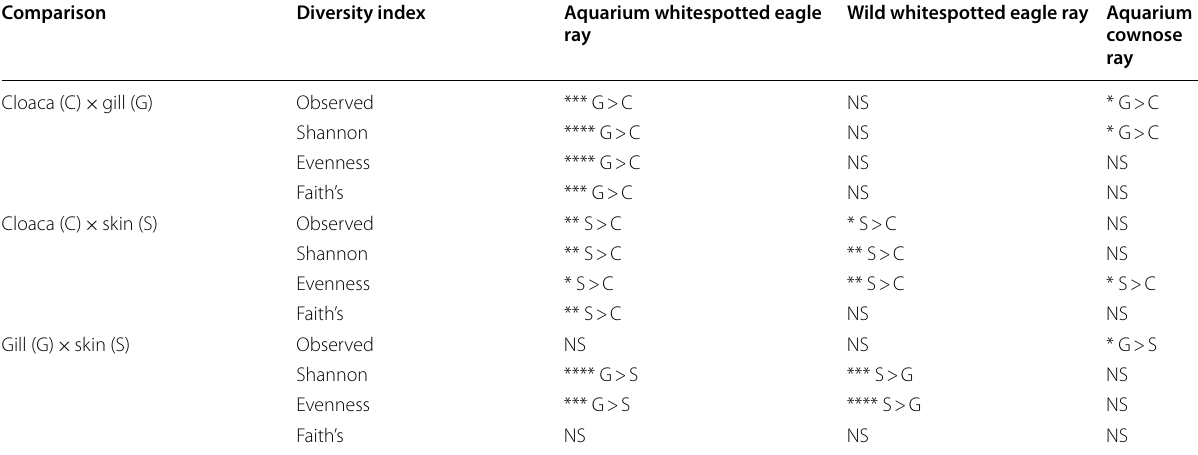
Table 5 Pairwise results for a one‑way analysis of variance (Kruskal–Wallis) for all α‑diversity metrics between different body sites for aquarium cownose ( Rhinoptera bonasus ) and wild and aquarium whitespotted eagle rays ( Aetobatus narinari )